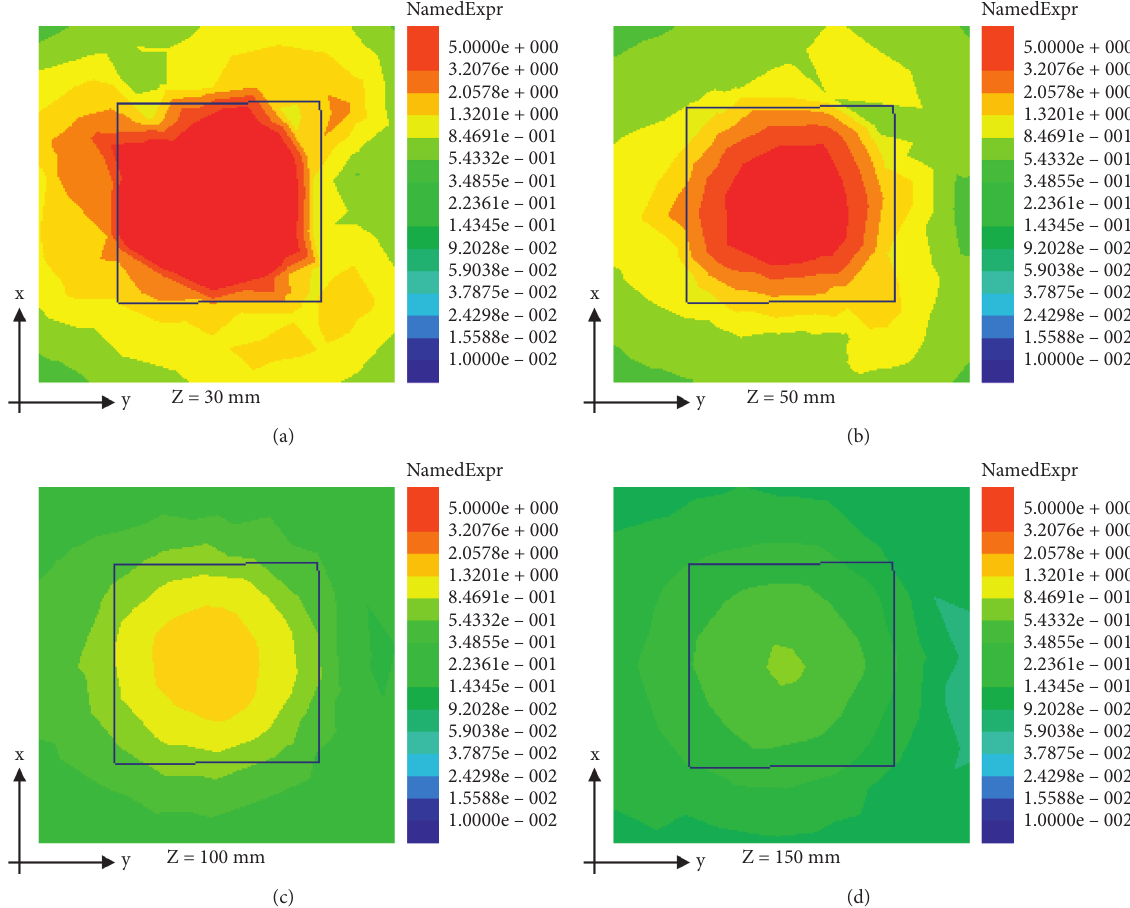
Figure 7: Simulated Ez distributions of the three-branch antenna at (a) Z � 30mm, (b) Z � 50mm, (c) Z � 100mm, and (d) Z �